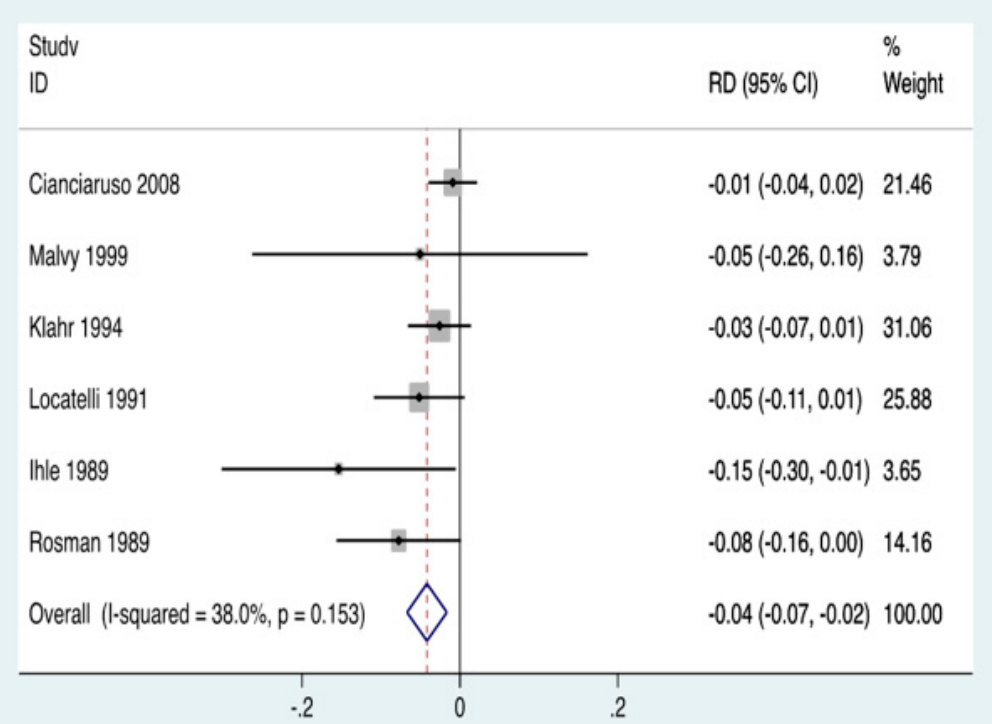
Figure 1. Effects of a plant-dominant low-protein diet on afferent arteriole contraction leading to reduced intra-glomerular pressure and nephron longevity (adapted from Kalantar-Zadeh and Fouque, N Engl J Med 2017) [25]. .